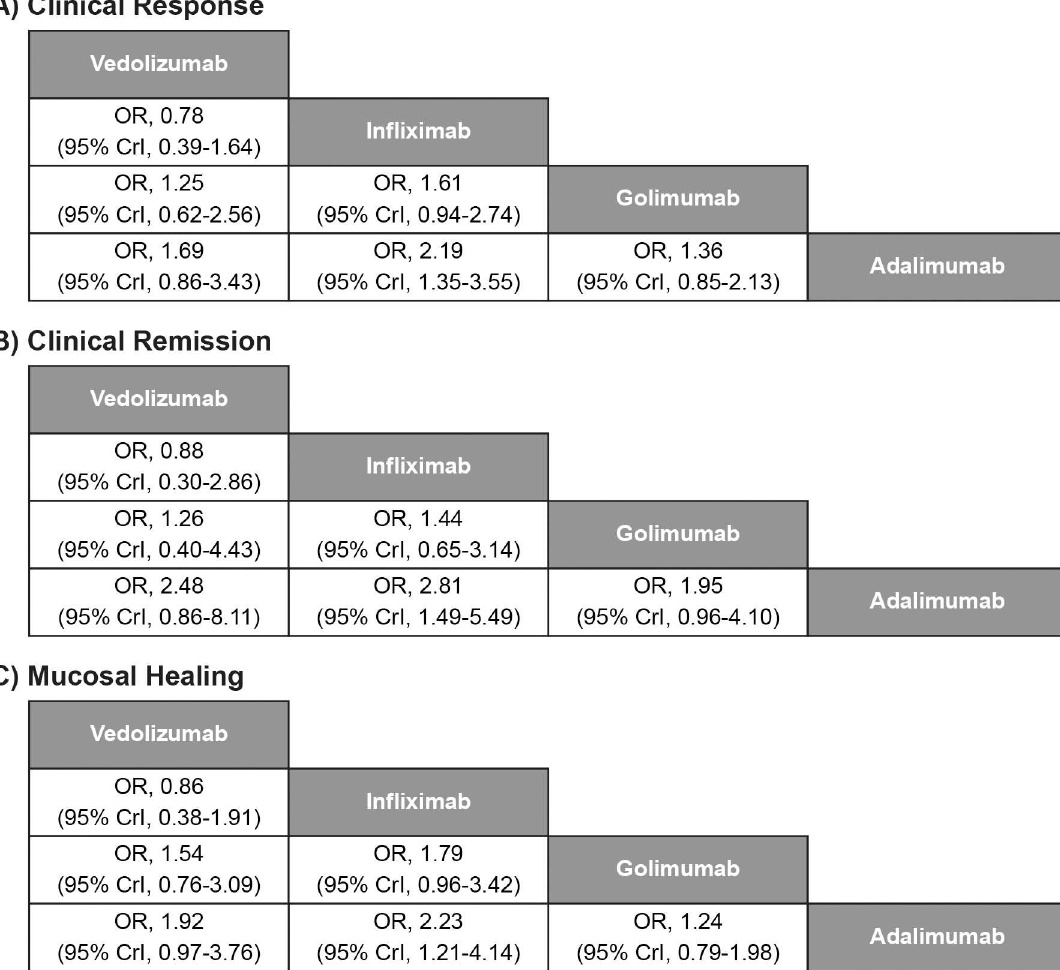
Fig 4. Comparative efficacy of biological agents as induction therapy for anti-TNF therapy-na ï ve subpopulation. CrI, credible interval; OR, odds ratio; TNF, tumour necrosis factor. Note: Treatment effect estimates come from Bayesian mixed-treatment comparison. ORs > 1.0 favour the treatment in the left upper square. To obtain ORs for comparison in the opposite direction, reciprocals shouldbe